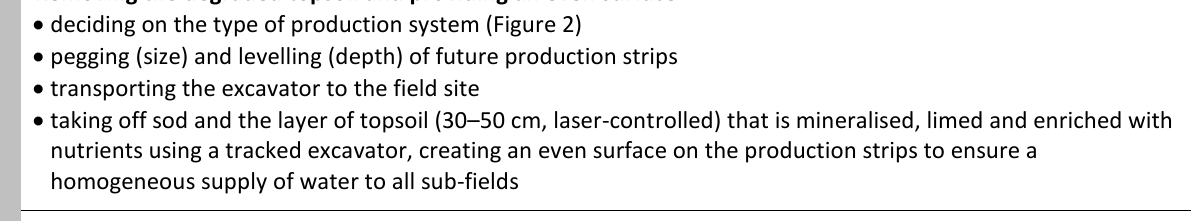
Table 2. The work steps required to establish Sphagnum cultures on bog grassland in Rastede (Lower Saxony, NW